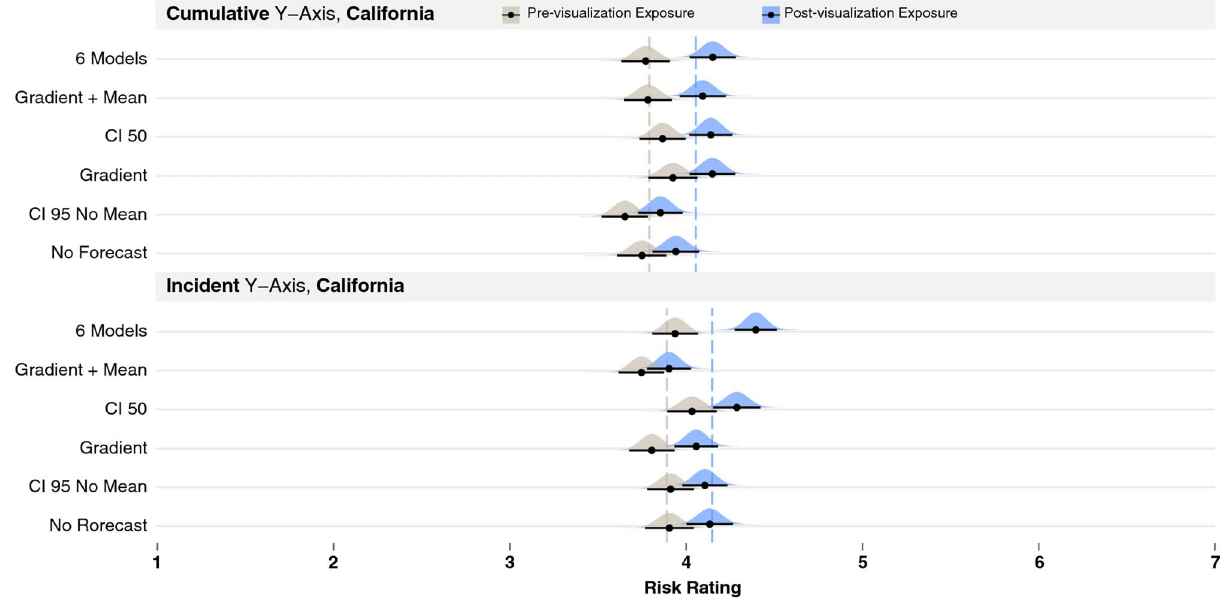
Figure 6. Results of the visualization comparison in Experiment 2 (ordered by size of the time point main effect), where pre-visualization risk judgments are colored gray and post-visualization judgments blue, for cumulative y-axis (top) and incident y-axis (bottom). Dashed lines show the mean pre- and post-visualization risk judgments for each y-axis group as a whole. Black bars show 95% confidence intervals around the mean (black dot) for each condition using the Cousineau–Morey method 44 and the density plots were generated from this